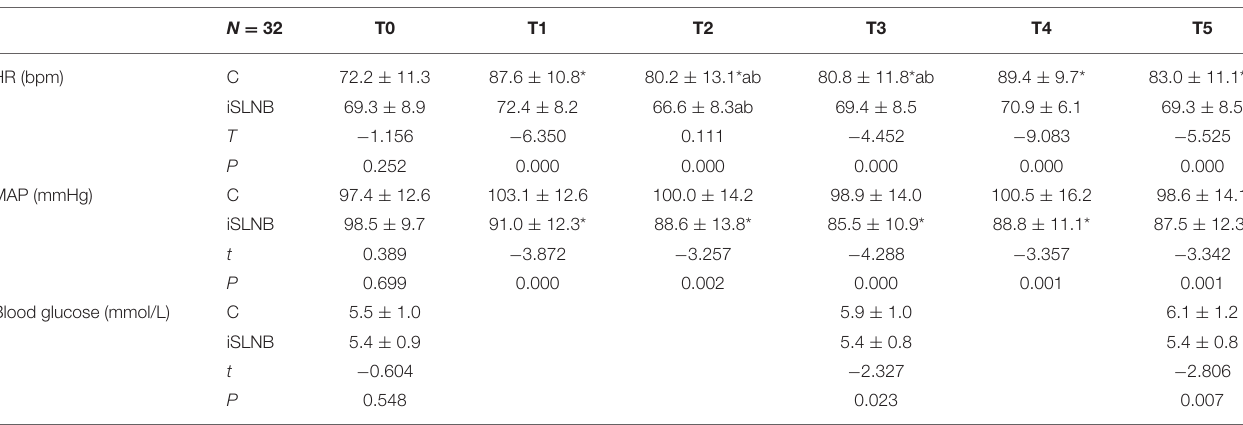
TABLE 4 | The hemodynamics and levels of blood glucose in two